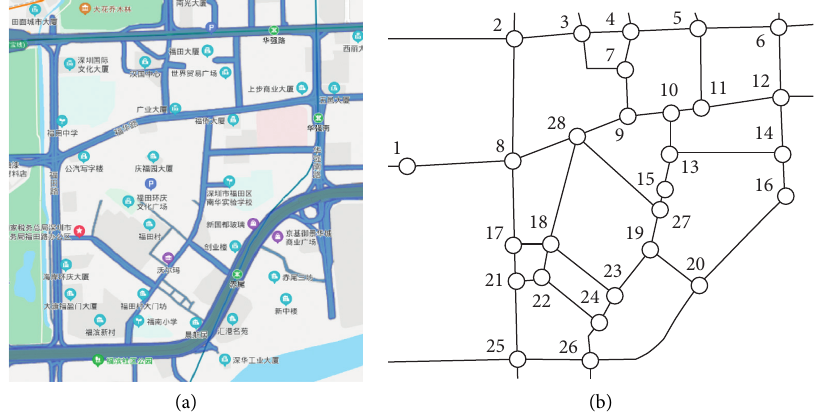
Figure 2: Roadway network of an old town in Futian District, Shenzhen City, China: (a) a map of research zone and (b) the topology of roadway network.